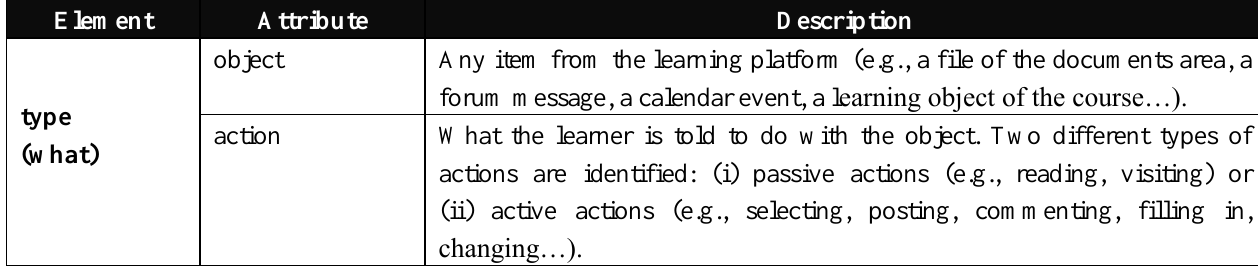
Table 3. Description of the attributes defined in the recommendation